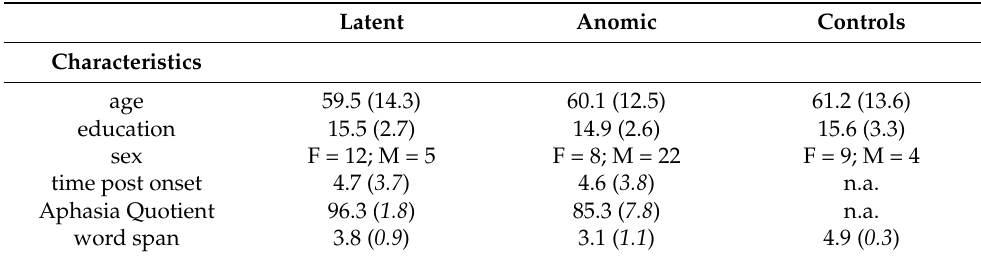
Table 1. Demographic